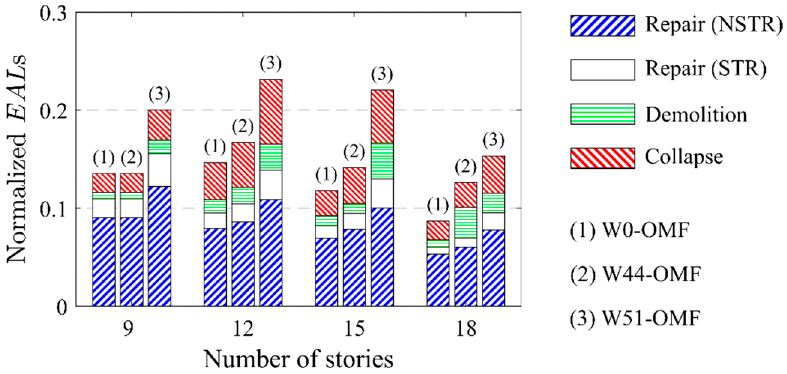
Figure 14. Normalized expected annual losses of all model buildings.